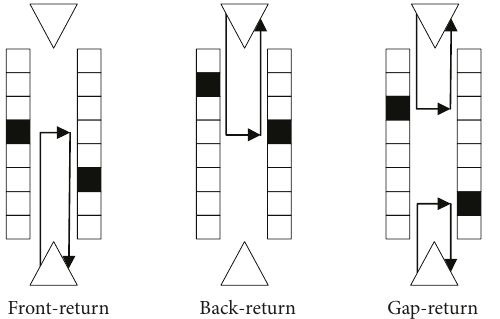
Figure 4: Access modes for subaisles with